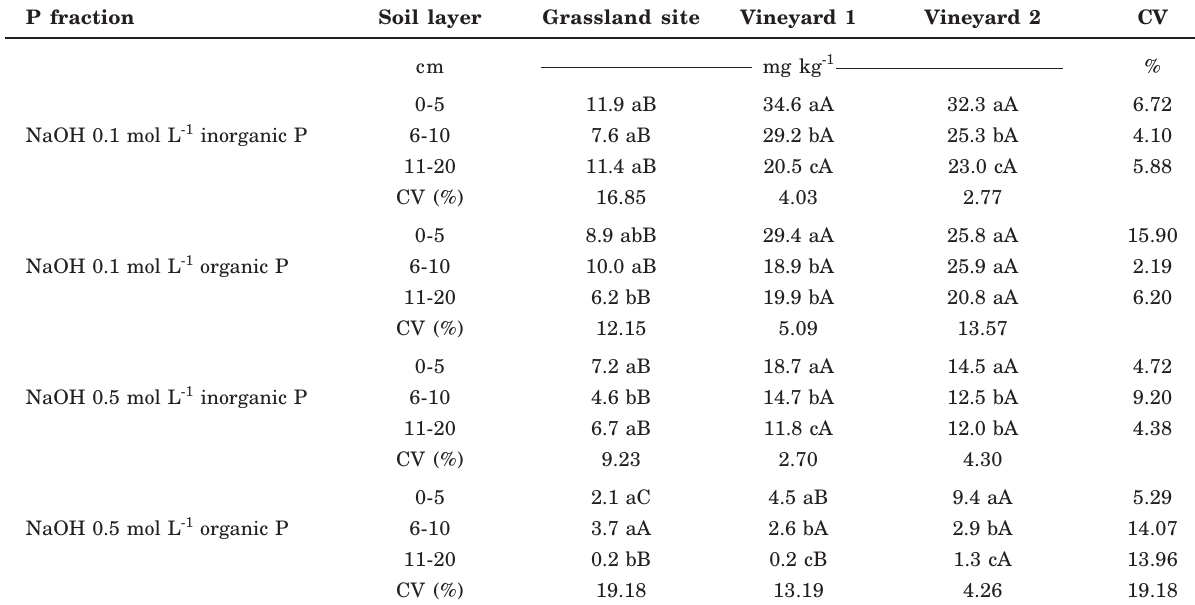
Table 3. Inorganic and organic P extracted with 0.1 and 0.5 mol L -1 NaOH from a sandy Typic Hapludalf soil of a grassland site, vineyard 1 (age 14 years) and vineyard 2 (age 30 years), in three